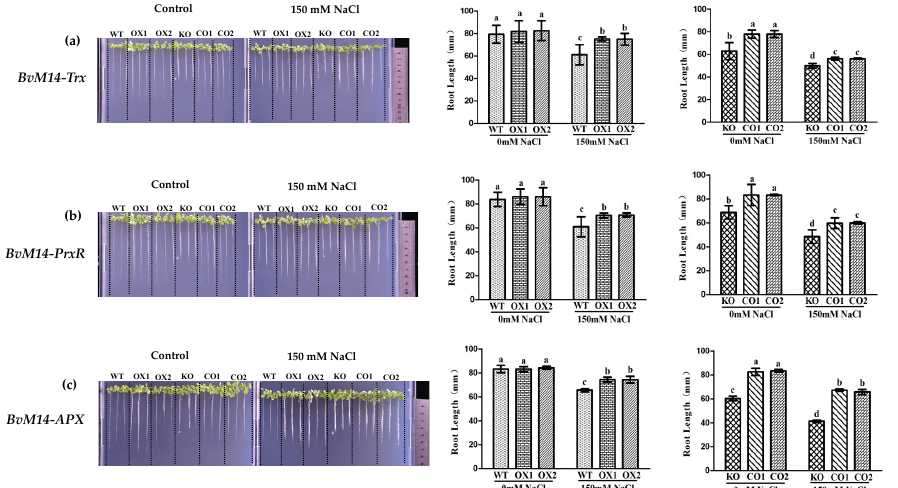
Figure 1. Effects of salt stress on the root length of seedings with different genotypes (WT, OX, KO, and CO): ( a ) Root length of WT and Trx -related plants under salt stress; ( b ) root length of of WT and PrxR- related plants under salt stress; ( c ) root length of WT and APX- related plants under salt stress. Data were analyzed by Duncan’s analysis of variance, and different lowercase letters (a, b, c, d) indicate differences in root